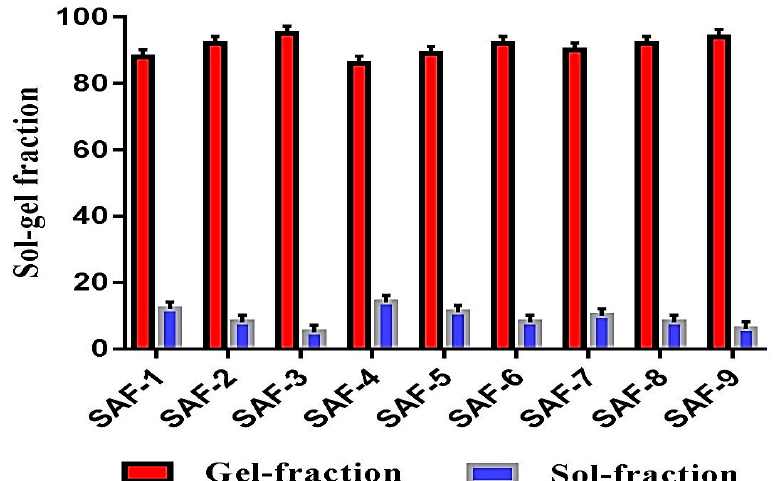
Figure 1. Sol–gel analysis of SA-co-poly(AMPS) hydrogels.